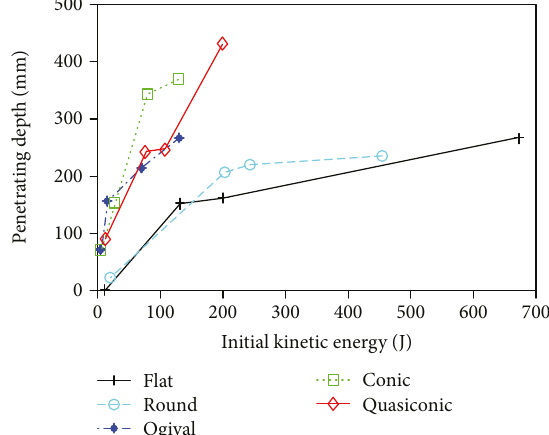
Figure 15: Penetrating capability of anchor tips with di ff erent shape.